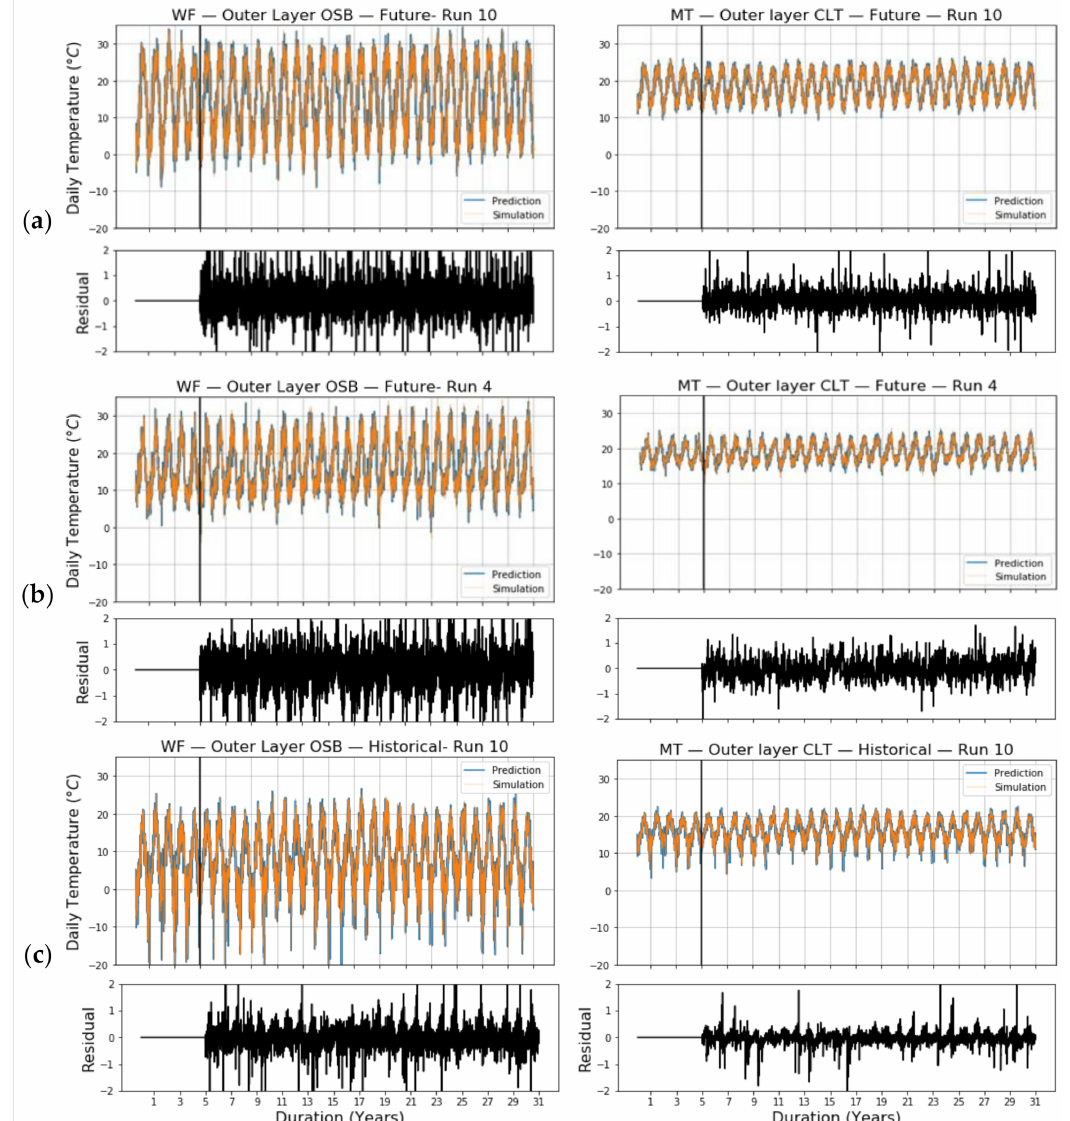
Figure 7. Comparisons of SVR predictions and hygrothermal simulation results for the temperature of the outer layer of OSB in wood frame (WF) and the outer layer of CLT in mass timber (MT) walls in the cities of ( a ) Ottawa, ( b ) Vancouver, and ( c )